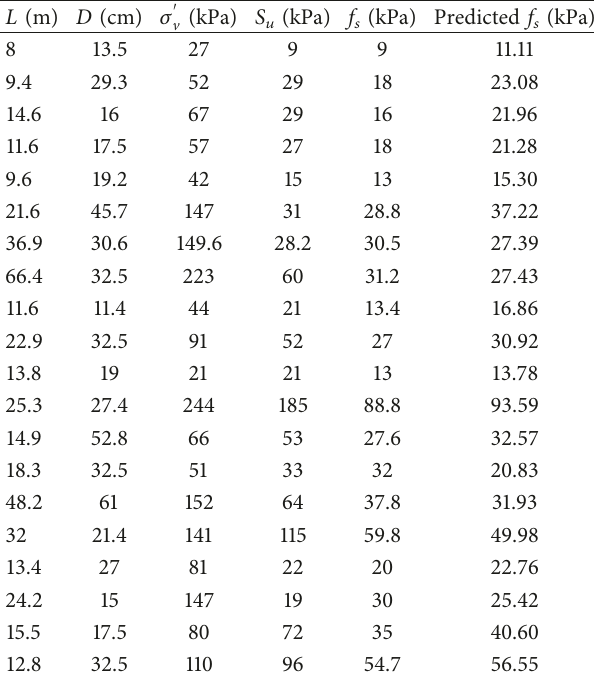
Table 5: Obtained predicted results by ST-LSSVM for testing